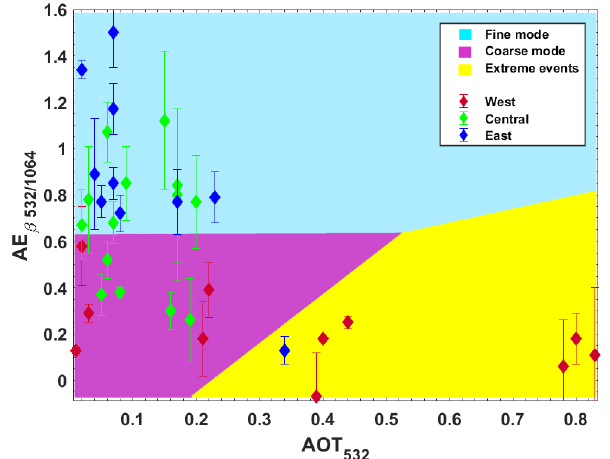
Figure 6. LR 532 versus δ p532 values from HSRL observations pre- sented by Groß et al. (2013) (colored dots), along with the se- lected datasets from the four EARLINET stations (symbols and er- ror